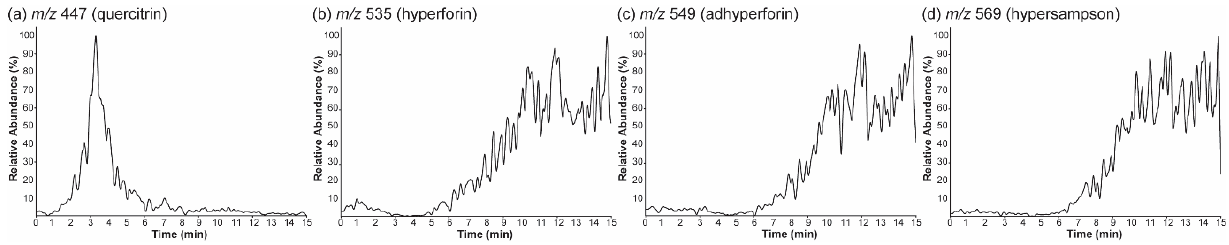
Figure 4. Selected ion monitoring (SIM) chronograms for the ions at ( a ) m / z 447, ( b ) m / z 535, ( c ) m / z 549, and ( d ) m / z 569, which were detected from a Hypericum leaf surface by nano-DESI MS. SIM experiments were performed with a mass window of ± 1 Da.